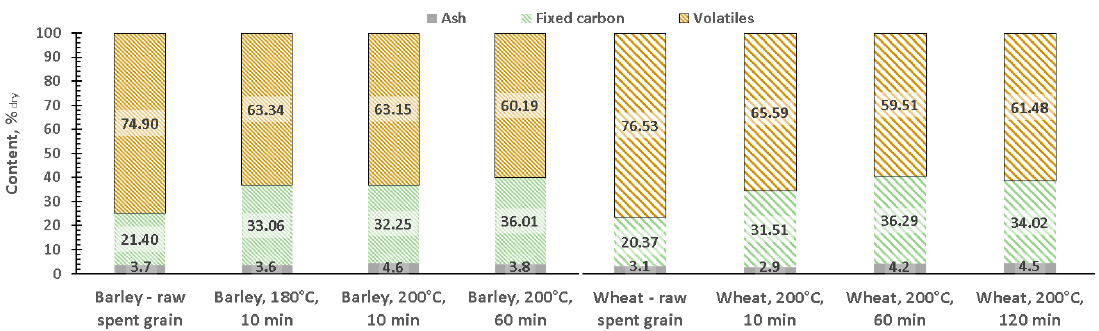
Figure 3. Results of the proximate analysis of all carbonized samples and dried feedstocks.